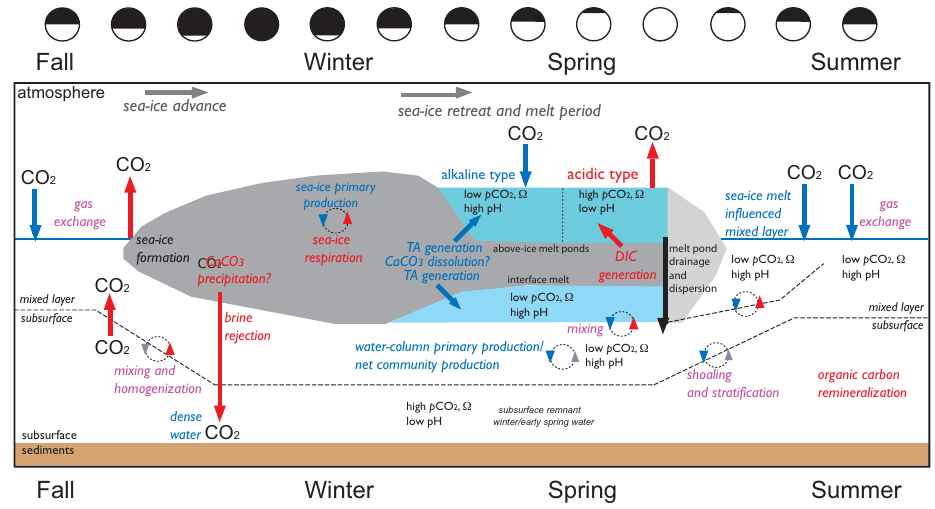
Figure 9. Seasonal schematic of processes impacting sea-ice and seawater CO 2 –carbonate chemistry in the western Arctic Ocean. The seasonal advance (freeze-up) and retreat (melting and breakup) of sea-ice is shown against approximate seasonal timing for both Arctic and Antarctic studies (both shown against season rather than month). Processes that can influence the decrease or increase of melt water or seawater p CO 2 are shown in blue and red respectively. For example, photosynthesis and calcification reduces CO 2 . In the water column, generalized changes in mixed-layer depth and surface water stratification are shown. Also shown in the figure are idealized surface ice melt ponds and below-ice interface melt water. The above-ice melt pond is differentiated into the observed alkaline and acidic types observed during the ICESCAPE project in 2010 and 2011 in the Chukchi